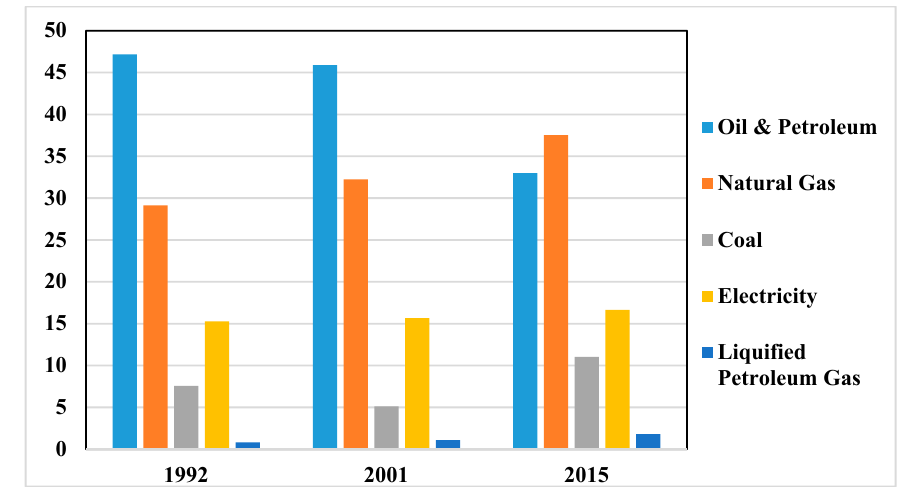
Figure 1. Percent share of fuels in the total energy mix: 1992–2015 [11–15] .